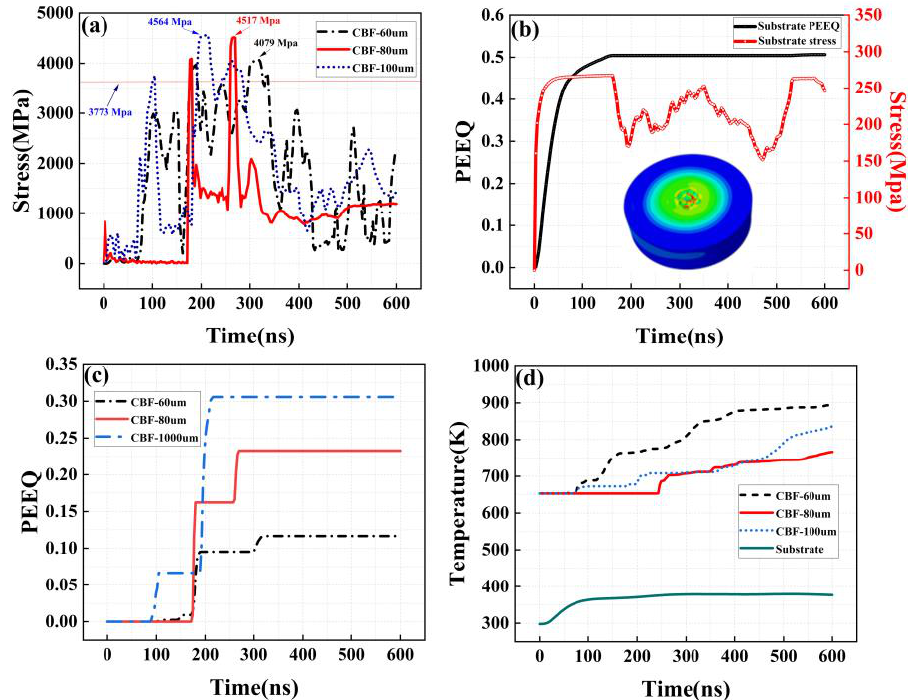
Figure 13. Simulation of the random deposition of Al–basalt fibers in multi-particles at a CBF content of 30 vol.%. ( a ) CBF stress evolution. ( b ) Evolution of the surface stress and equivalent plastic strain in the aluminum matrix. ( c ) CBF equivalent plastic strain evolution. ( d ) Temperature evolution of the aluminum matrix and basalt fibers.